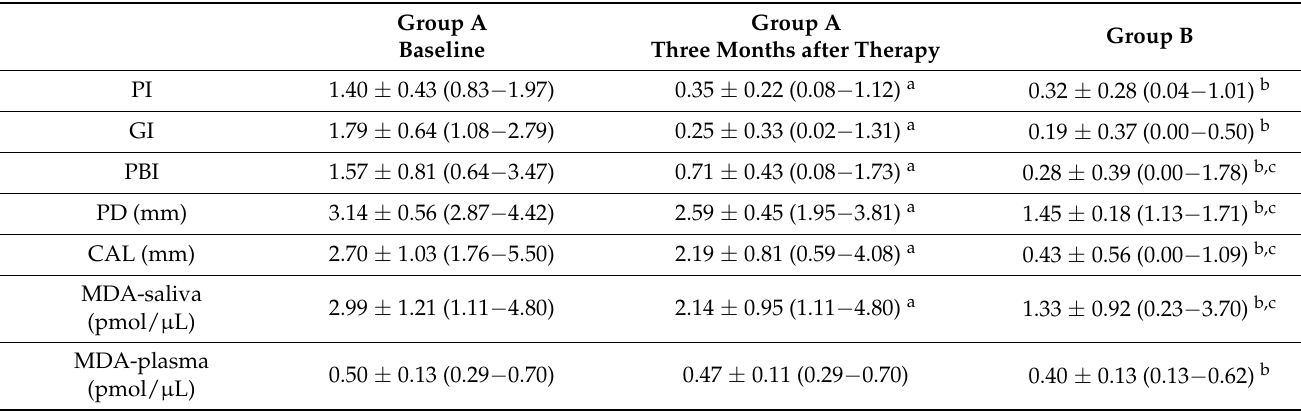
Table 2. Periodontal indices and MDA levels at baseline and three months upon therapy completion (mean ± SD, minimum −